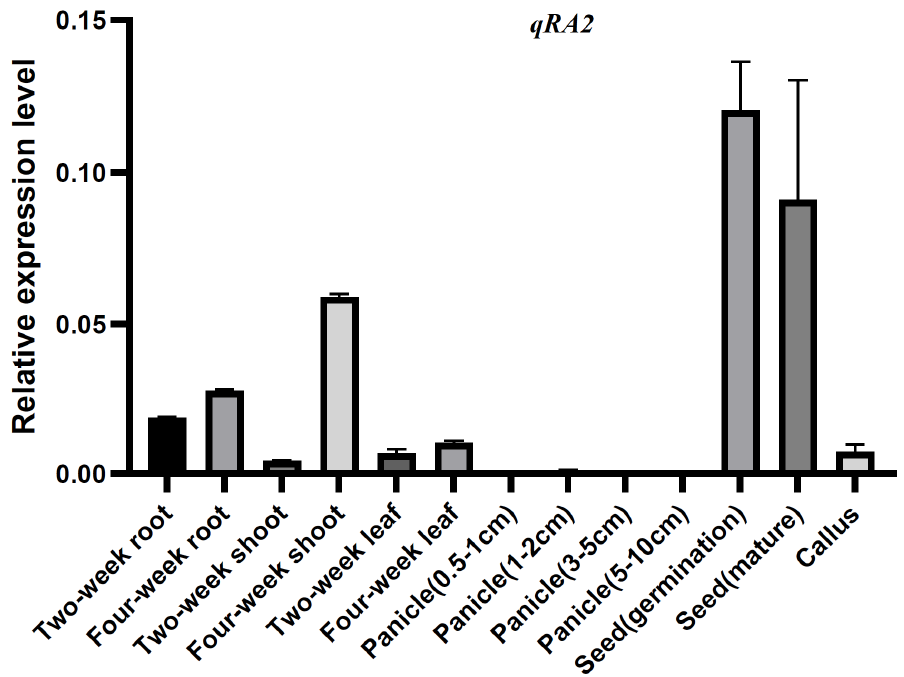
Figure 4. Determination of the expression patterns of qRA2 via qRT − PCR. RNA samples were extracted from different tissues of Jiafuzhan, including roots, shoots, and leaves of two-, four- and six-week-old seedlings, spikelets of 0.5–1 cm, 1–3 cm, 3–5 cm, and 5–10 cm in length, germinating and mature seeds, and calli. Data represent the mean and standard deviation of three biological replicates. Three technical replicates for each biological sample were used. The error bar represents the standard deviation (SD) of the value from three independent biological samples.